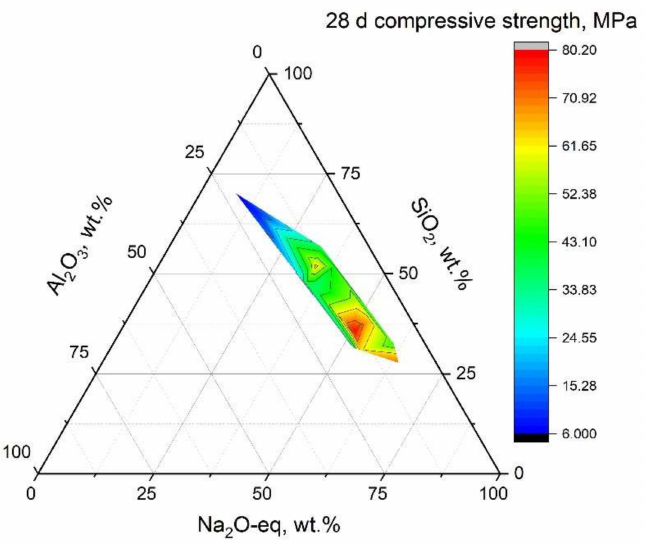
Figure 2. Pseudo-ternary plot of 28 d compressive strength with binder composition (data from